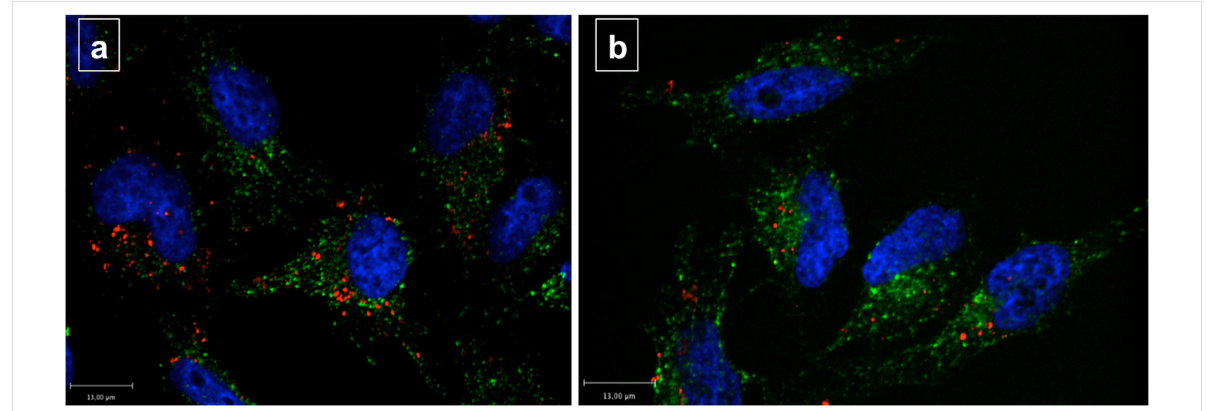
Figure 7: Fluorescence image of Hela cells which were incubated with SCIONs (iron concentration 5 µg/mL, incubation time 4 h), blue = DAPI (nuclei), green = Transferrin Alexa Fluor ® 488 conjugate (cytosol), red = Alexa Fluor ® 555 (SCIONs); (a) Control cells without siRNA treatment;